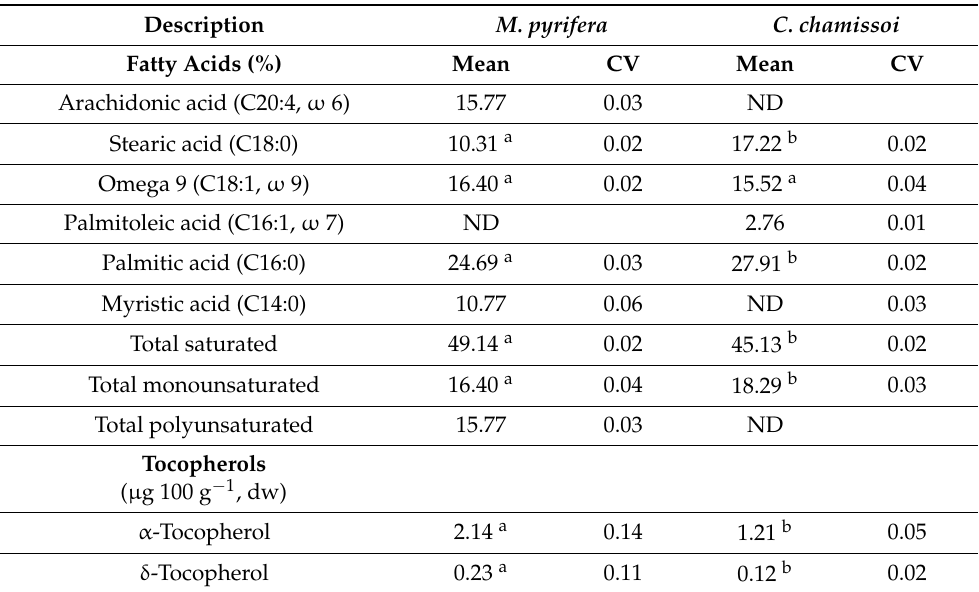
Table 3. Composition of saturated and unsaturated acids of brown ( M. pyrifera ) and red ( C. chamissoi ) Peruvian